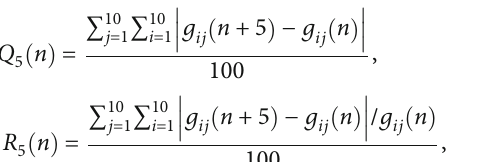
Figure 5: Membrane voltages of neurons in the song premotor pathway. Before the song, HVC and RA projection neurons oscillate at about 50 Hz (b). At 1.0 s, 1.2 s, and 1.4s, the fi rst HVC simulate song neural activity. During the song, HVC almost 65ms for RA neurons to return to the oscillatory